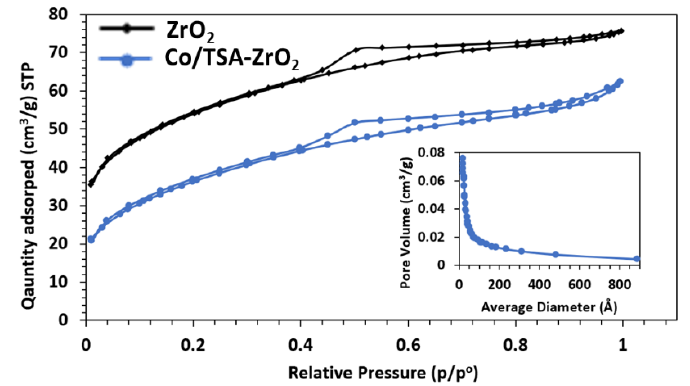
Figure 3. Nitrogen physisorption analysis of ZrO 2 and Co/TSA-ZrO 2. TEM images (Figure 4) of Co/TSA-ZrO 2 confirmed the presence of Co, W, Zr, Si, and O in the synthesized catalyst. Further, mapping of W and Co showed absences of any agglomeration of W (even at 30% loading of TSA) and Co, indicating higher dispersion of metal centres throughout the matrix. The Co/TSA – ZrO 2 showed overall bulk morphology similar to typical ZrO 2 [35]. Figure 4. TEM and Elemental mapping of Co/TSA – ZrO 2. 2.2. Catalytic Activity 2.2.1. Oxidation of Alcohol To optimize reaction conditions, oxidation of benzyl alcohol and styrene were se- lected as model reactions. Further to confirm the conversion of substrates is solely due to the activity of the Co/TSA – ZrO 2 , all the reactions were carried out under catalyst-free conditions. The absence of major oxidation products of (1) benzyl alcohol, i.e., benzal- dehyde and benzoic acid as well as (2) styrene, i.e., styrene oxide, benzaldehyde, phe- nylacetaldehyde, and 1-phenylethane-1,2-diol, confirmed that no oxidation occurred under catalyst-free conditions. Oxidation of Benzyl Alcohol The effect of various parameters such as reaction temperature, catalyst dosing, reac- tion, and time was studied comprehensively to achieve optimum activity Co/TSA – ZrO 2 with maximum selectivity of benzaldehyde.